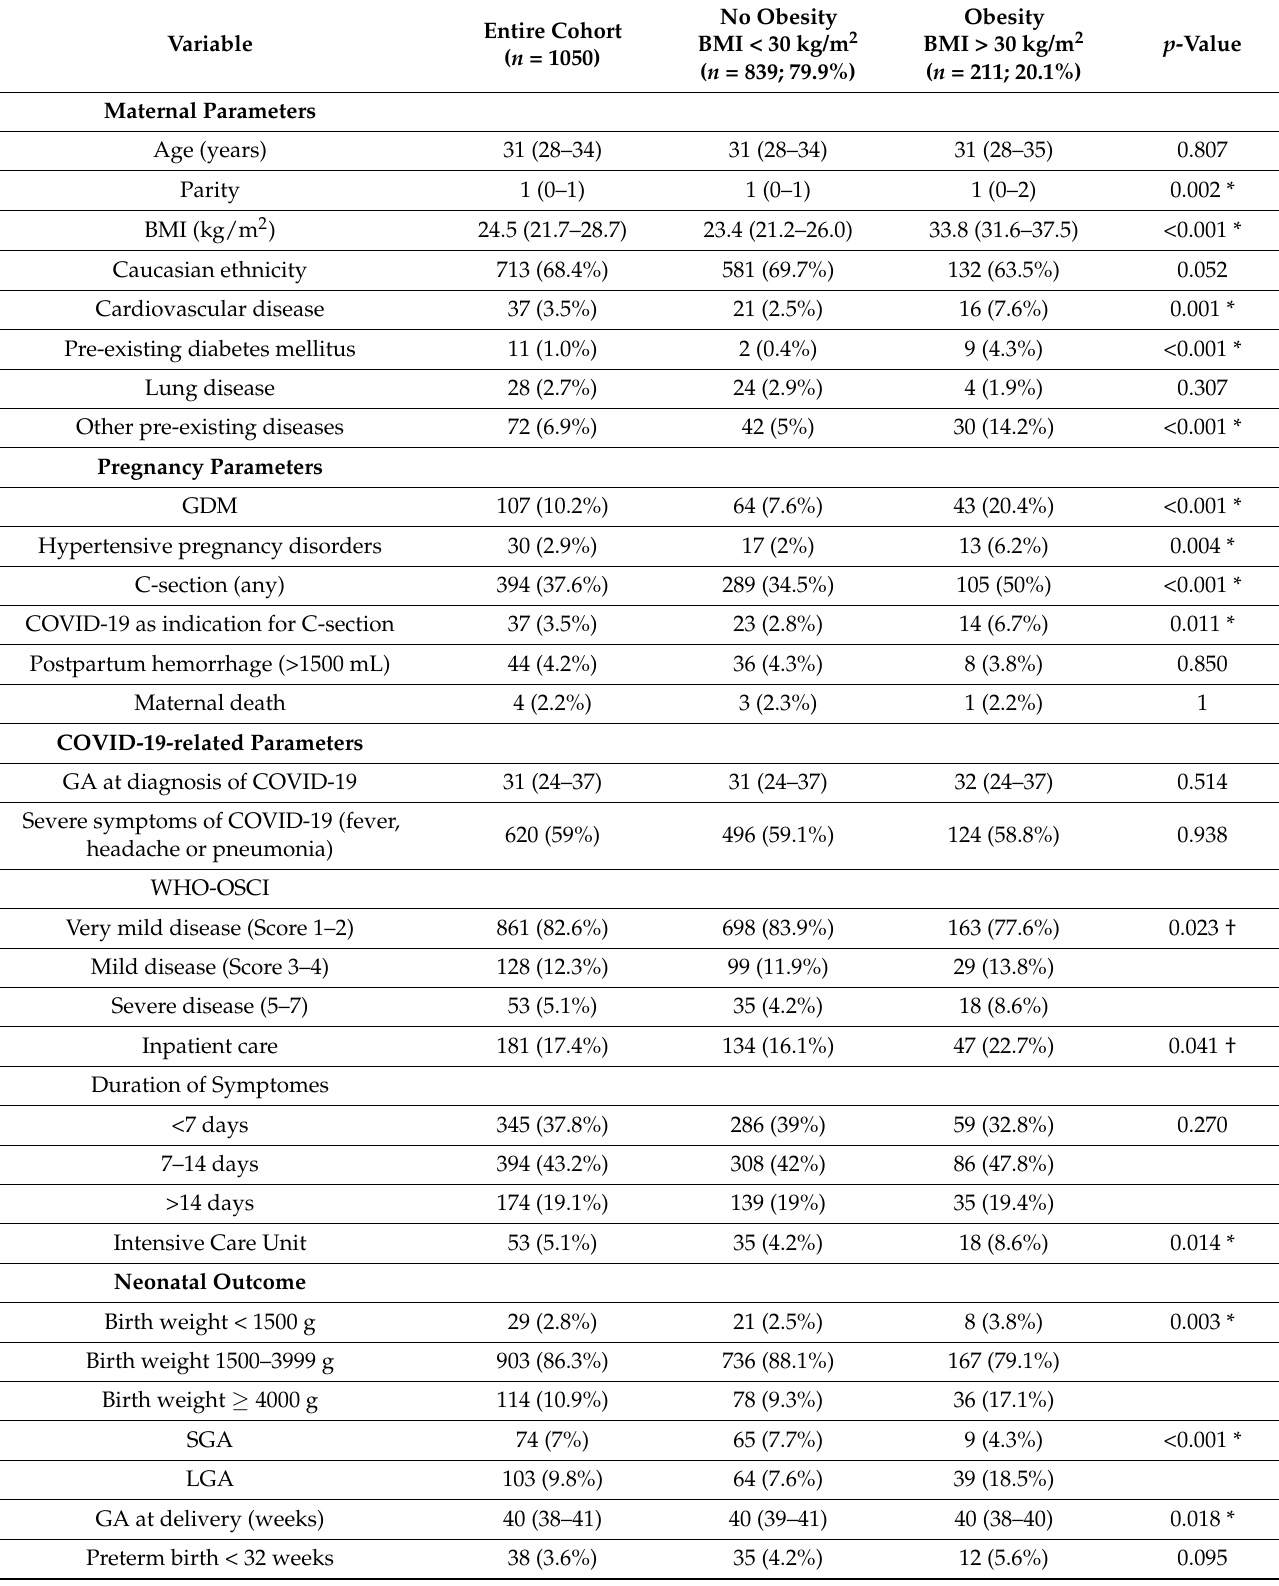
Table 2. Cohort characteristics including maternal, pregnancy, COVID-related and neonatal outcome parameters of total cohort ( n = 1050) and the comparison between women without obesity ( n = 839) and with obesity ( n =